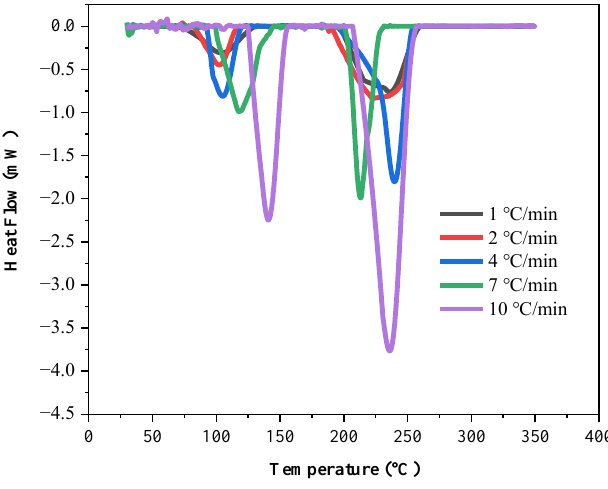
Figure 1. Endothermic curves of LP30 at different heating rates.